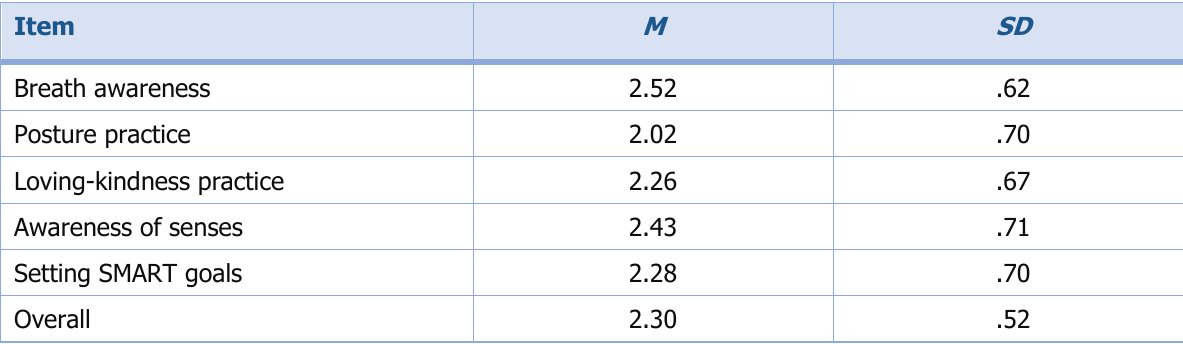
Table 6. Descriptive Statistics for Participants’ Intention to Apply Mindfulness